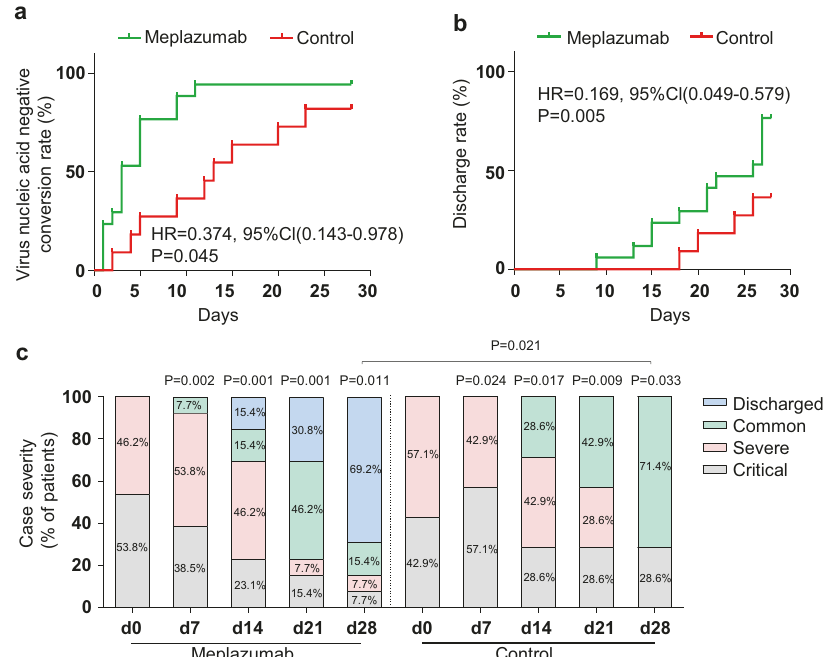
Fig. 3 a Time to virus-negative conversion. The P value was calculated by Cox regression analysis, and P value 0.045 and HR 0.374, 95% CI [0.143 – 0.978]). The median of time to negative was 3 days (95% CI [1.5 – 4.5]) for the meplazumab cohort and 13 days (95% CI [6.5 – 19.5]) for the control cohort. b Analysis of time to discharge. The P value was determined using Cox regression analysis. c Distribution of case severity in severe and critical patients. The P values were from Ordinal regression. The P value comparing between baseline (Day 0) and each time point was shown on the top of the column, and the P value comparing between meplazumab and control at Day 28 was shown on the